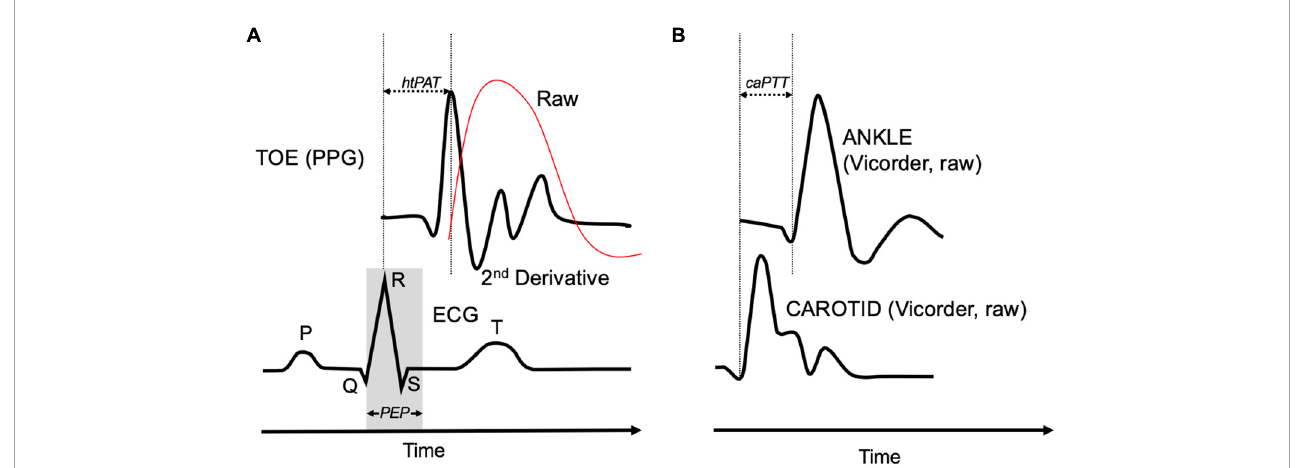
FIGURE1 (A) Heart-toe pulse arrival time (htPAT) used for heart-toe pulse-wave velocity (htPWV) calculation (red line = raw PPG signal) and (B) carotid-ankle pulse transit time (caPTT) used for carotid-ankle pulse-wave velocity (caPWV) calculation. Alignment of raw foot and 2nd derivative peak. ECG, electrocardiogram; PEP, pre-ejection period; PPG,